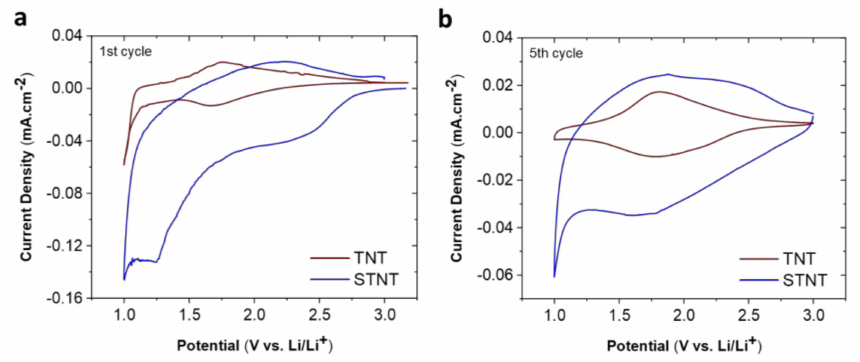
Figure 4. Cyclic voltammograms of TNT and STNT samples ( a ) 1st cycle; ( b ) 5th